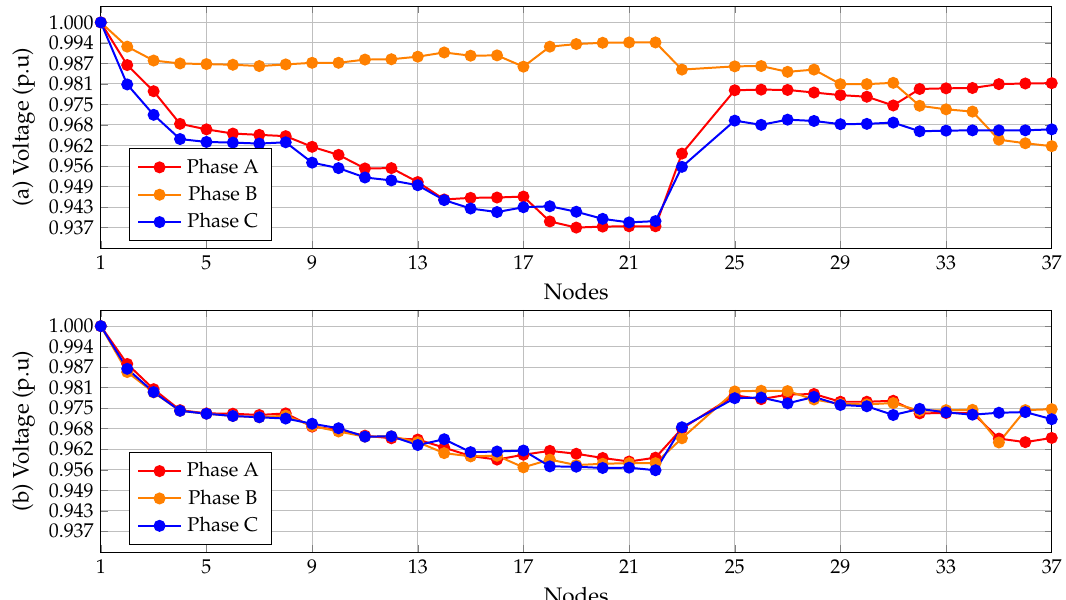
Figure 17. Voltage profiles for the IEEE 37-node test system: ( a ) modified benchmark case and ( b ) DVSA